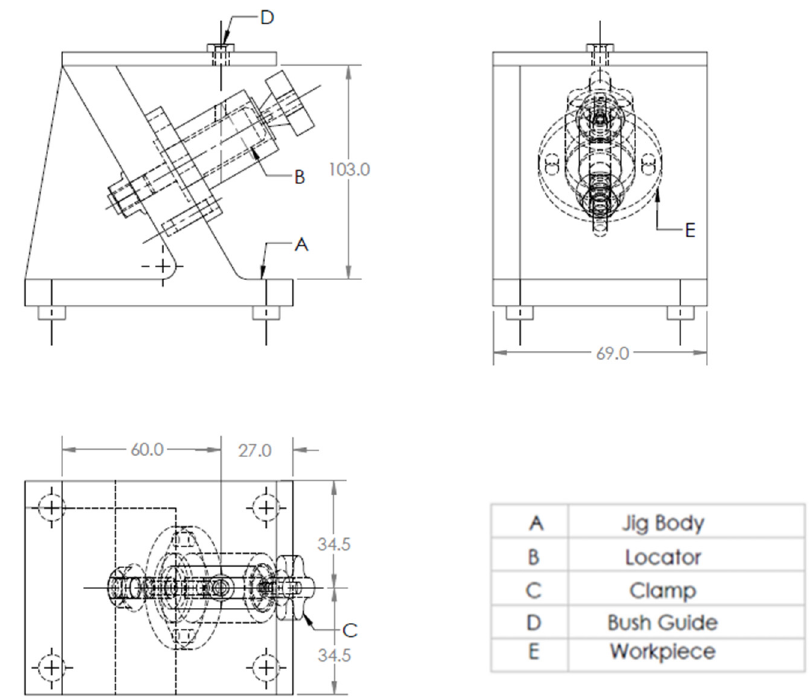
Figure 29. The drawing and isometric of the part.